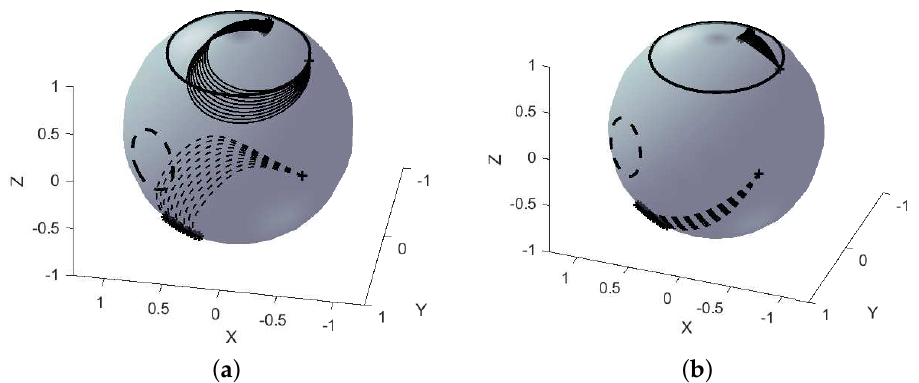
Figure 5. Correcting for antenna pointing. The initial trajectories constructed between the points ( a ) and the same trajectories after choosing the c i values using reinforcement learning ( b ). The initial points are indicated by + and the final points by ∗ (initial and final points from Equation